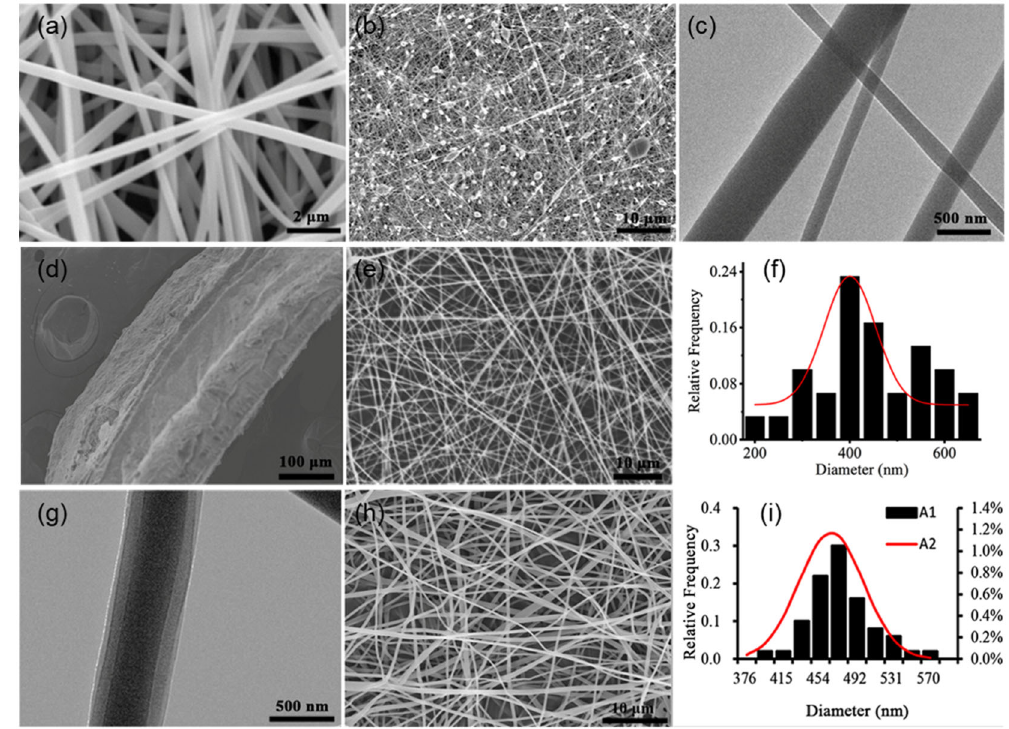
Fig. 4 Microscopic morphology of the bioarti fi cial blood vessels: a Uniform nano fi ber fi laments. b fi bers with beaded structure. c Lack of core/shell structure. d Three-layer structure of bioarti fi cial blood vessel. e Representative SEM image of uniaxial electrospun nano fi ber.